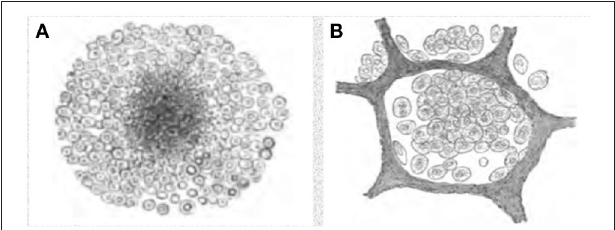
FIGURE 1 | Characteristics of primary and post-primary TB. (A) Granuloma of primary TB, (B) Early alveolar infiltrate, Assmann’s focus, of post-primary TB. Primary and post primary TB are distinct disease entities caused by the same organism, just as chicken pox and shingles are distinct disease entities caused by varicella zoster virus. Primary TB produces primary granulomas while post-primary TB begins with the early infiltrate. Over a period of months, most early infiltrates regress asymptomatically, but some spread via bronchi as obstructive lobular pneumonia, develop into caseous pneumonia that fragments to produce cavities or to become the focus of post-primary granulomas and fibrocaseous disease. The pathology of these lesions has been described since the 1850’s and they have been monitored by x-ray since the 1920’s. These drawings are from Cornil and Ranvier (